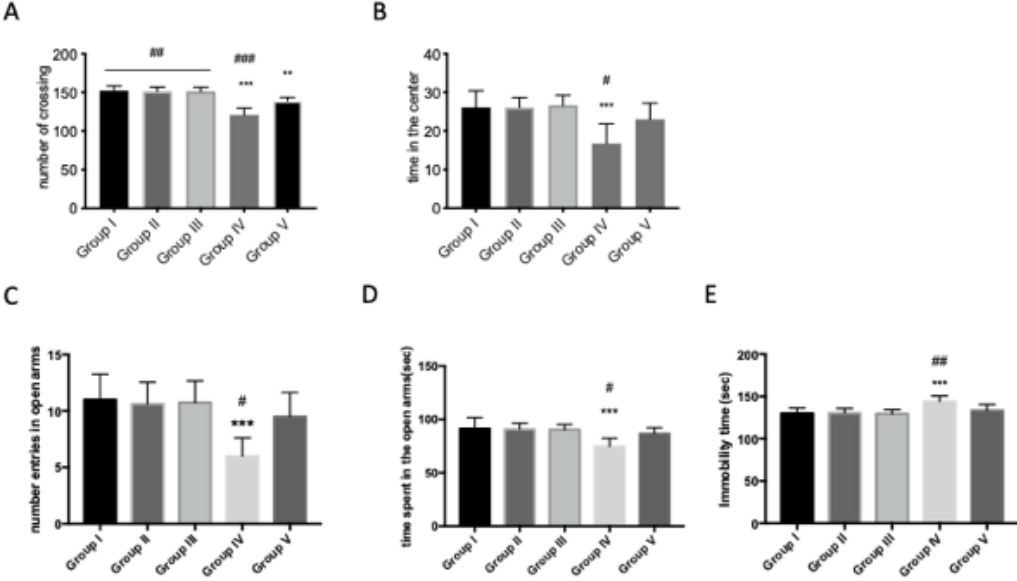
Figure 3. E ff ect of quercetin on anxiety-like behavior changes in AFB1 mice. Group I (control); Group II (veh + control); Group III (quercetin-only); Group IV (AFB1); Group V (afb1 + quercetin). E ff ects of 45 days of AFB1 administration on anxiety behaviors in OF. Anxiety is calculated as mean of the total time in the center, in seconds. AFB1 decreased the time spent in the center of the arena. ( A ) Regarding the number of crossings, AFB1 showed a decrease on f number of crossings ( B ). In EPM, anxiety was calculated in the number of entries in open arms ( C ); AFB1 reduced the number of entries in open arms, as well as the time spent in open arms ( D ). Quercetin showed an increase of number of entries and time spent in open arms ( C,D ). In the FST, chronic AFB1 administration had an e ff ect on the immobility time; quercetin reduced the immobility time compared to AFB1 mice ( E ). Values are mean ± SEM of 8 mice / group. * p < 0.05 vs. veh control group; # p < 0.05 vs. AFB1 + quercetin.